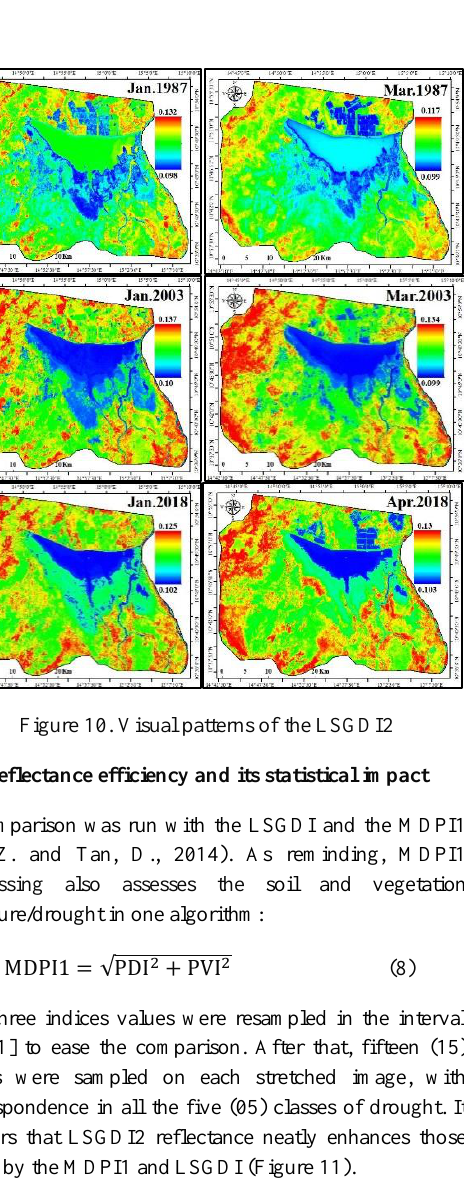
Figure 12. Compared areas statistics for the three indices